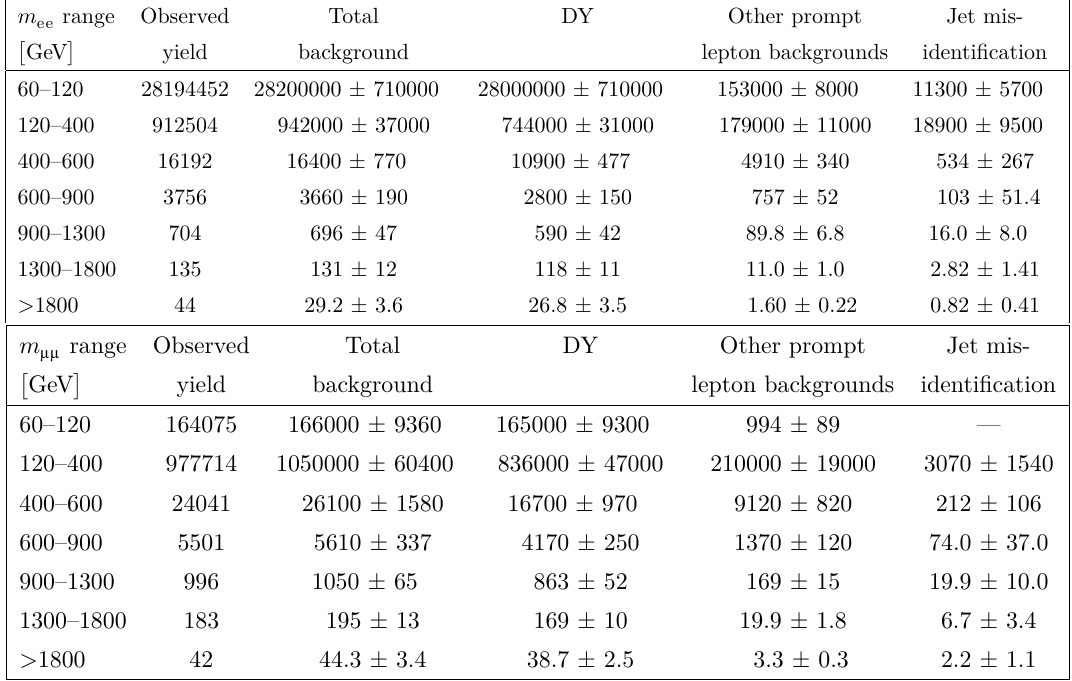
Table 4 . Observed and expected background yields for different mass ranges in the (upper) di- electron channel and (lower) dimuon channel. The sum of all background contributions is shown as well as a breakdown into the three main categories. The quoted uncertainties include both the statistical and the systematic